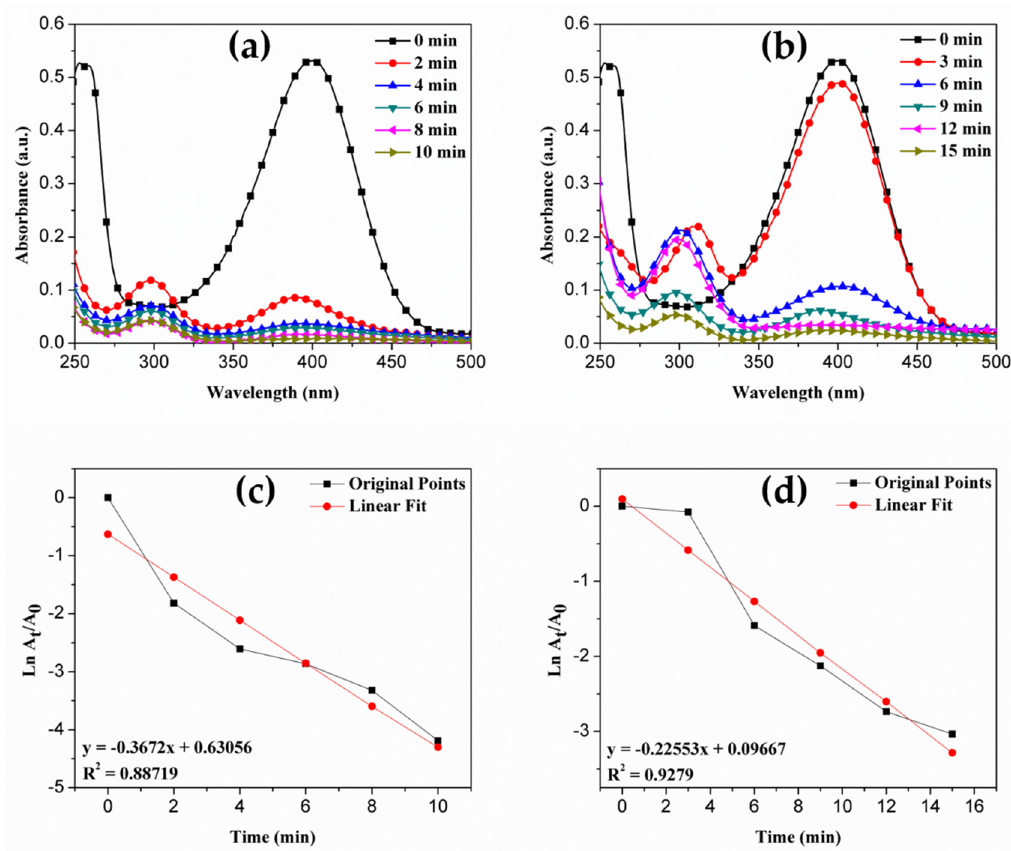
Figure 8. Time-dependent UV-Vis spectra representing the catalytic reduction of 4-NP into 4-AP using ( a & b ) nanocatalyst SNC-PC-X1 and SNC-PC-X2, respectively; and linear plot of –ln(At / Ao) versus reduction time for ( c & d ) nanocatalyst SNC-PC-X1 and SNC-PC-X2, respectively.